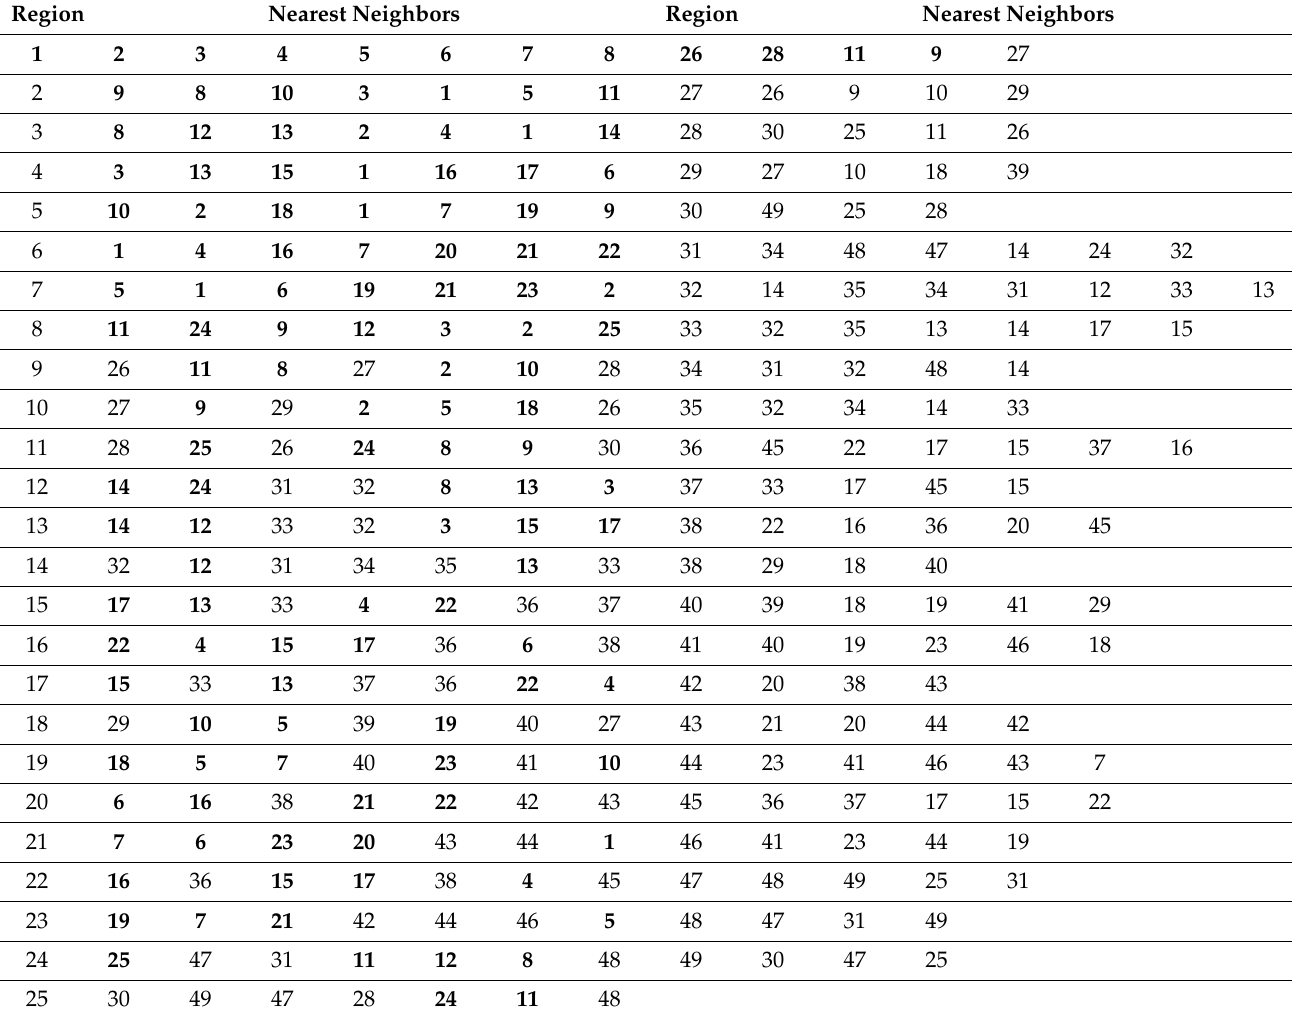
Table 1. Nearest neighbors of each of the 49 regions that are shown in Figure 3. Regions in the initial set of 25 are numbered with bold typeface.